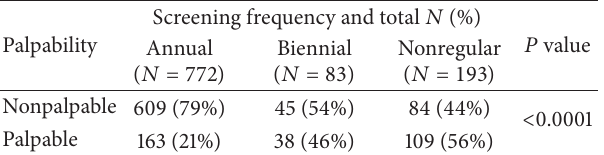
Table 4: Tumor palpability and screening frequency.